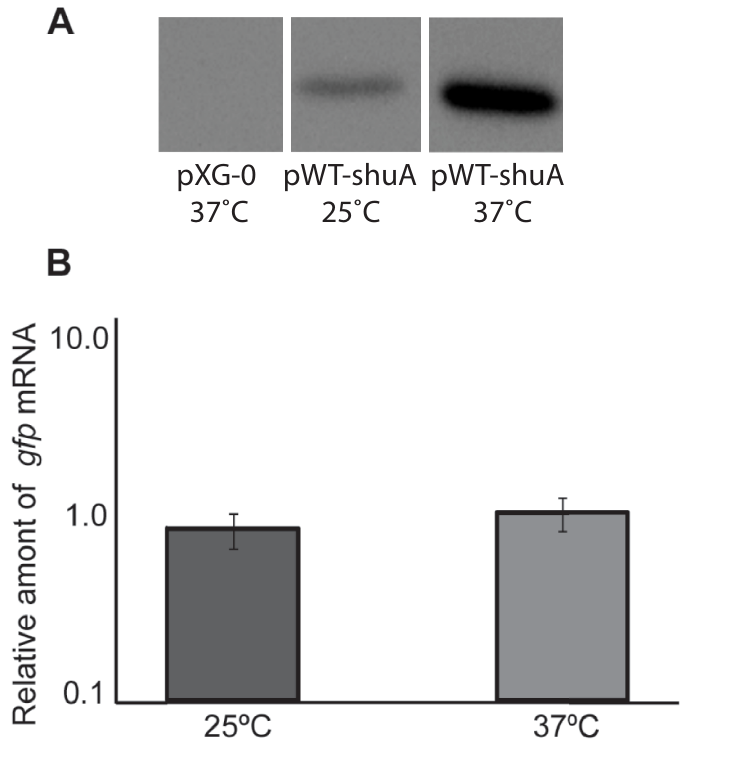
Fig 6. Sequences composing the shuA FourU thermometer are sufficient to confer post-transcriptional thermoregulation onto gfp expression. A) E . coli strain DH5 α containing pWT- shuA or pXG-0, as a vector control, was cultured to stationary phase at the temperatures indicated. A Western blot was performed using whole-cell lysates generated from an equal number of cells and anti-Gfp monoclonal antibodies. Results shown in this panel were spliced from the same underlying western blot experiment for which the underlying data are presented in the S5 File of this Correction notice. B) Quantitative Real-time PCR was conducted using RNA isolated from E . coli DH5 α carrying pWT- shuA following growth of the strain to stationary phase at 25˚C or 37˚C. gfp mRNA levels were normalized to rrsA measured in each sample and expressed relative to the amount of gfp transcript measured in the first 25˚C sample. All data are representative of three biological replicates and error bars represent one standard deviation. Assuming a confidence interval of 95% (p � 0.05), no significant difference exists between the relative levels of gfp transcript measured from pWT- shuA following growth of the strain at 25˚C or